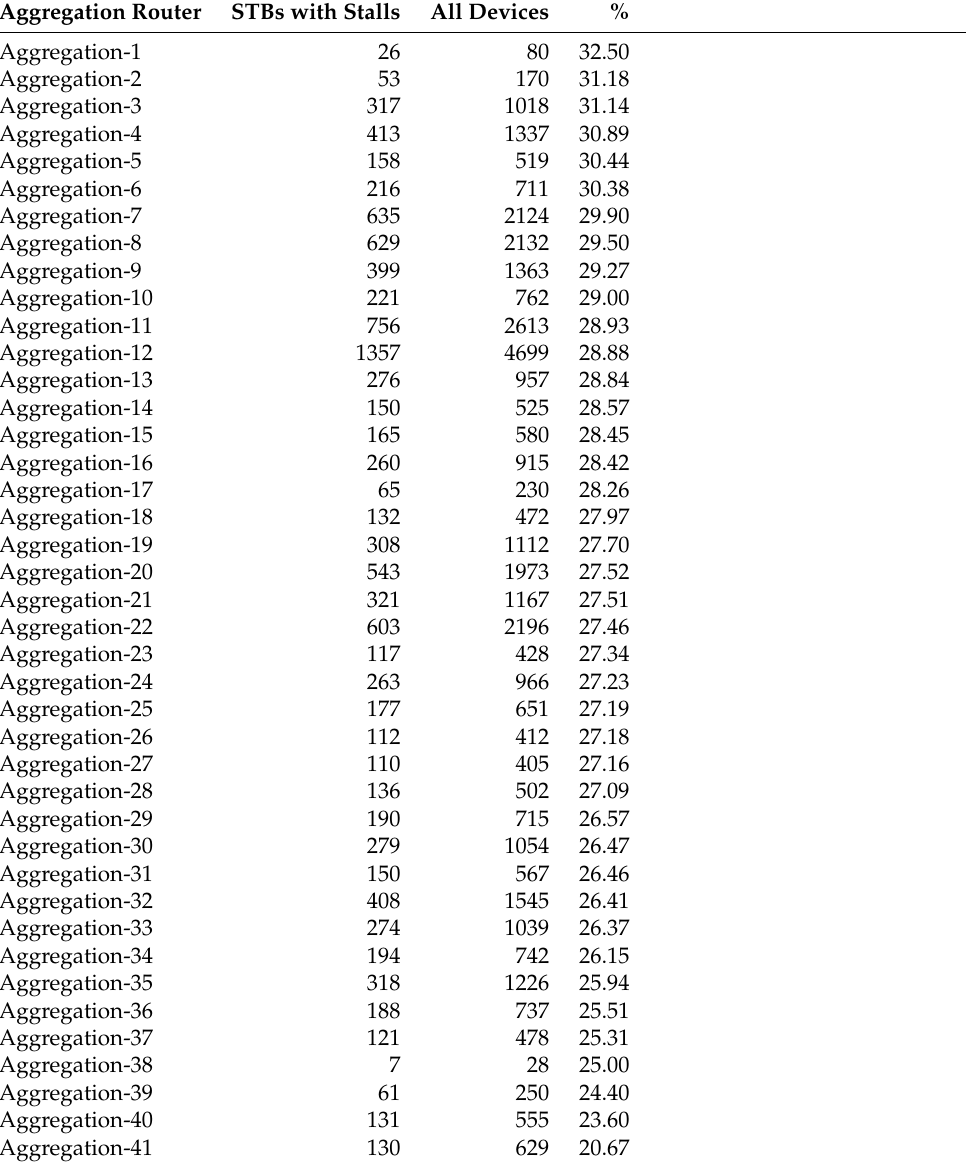
Table 2. Stalls per aggregation